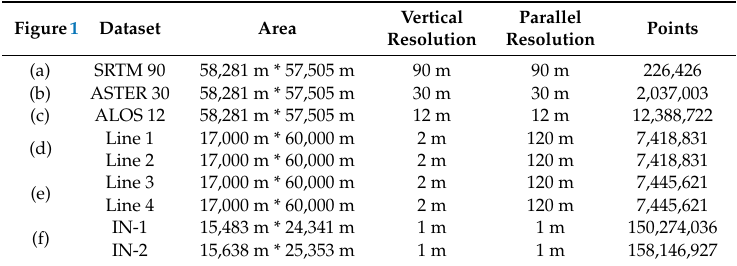
Figure 1. Datasets used in experiments. ( a – c ) are the simulated point clouds of SRTM 90, ASTER 30 and ALOS 12, respectively, which have di ff erent resolutions in the same region; ( d , e ) are simulated LiDAR point clouds in flat and rough terrain, where Line 1 and Line 2 ( d ), Line 3 and Line 4 ( e ) are only partial overlapped; ( f ) is the simulated light detection and ranging (LiDAR) point clouds from airborne LiDAR point clouds and ( g ) are detail comparison of three datasets in DEM and contours, respectively. Table 1. Information on simulated LiDAR point clouds.